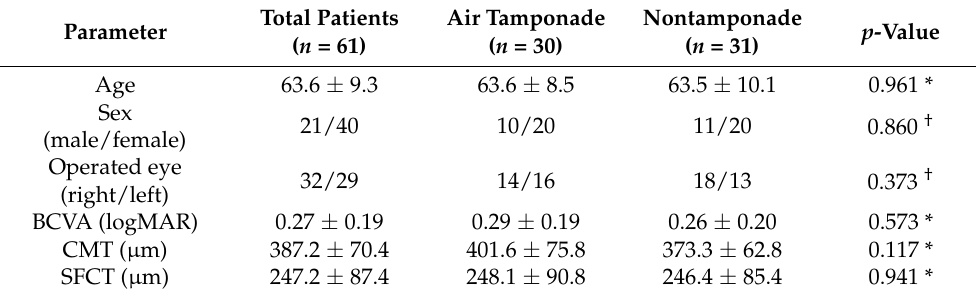
Table 1. Comparison of patient characteristics at baseline.